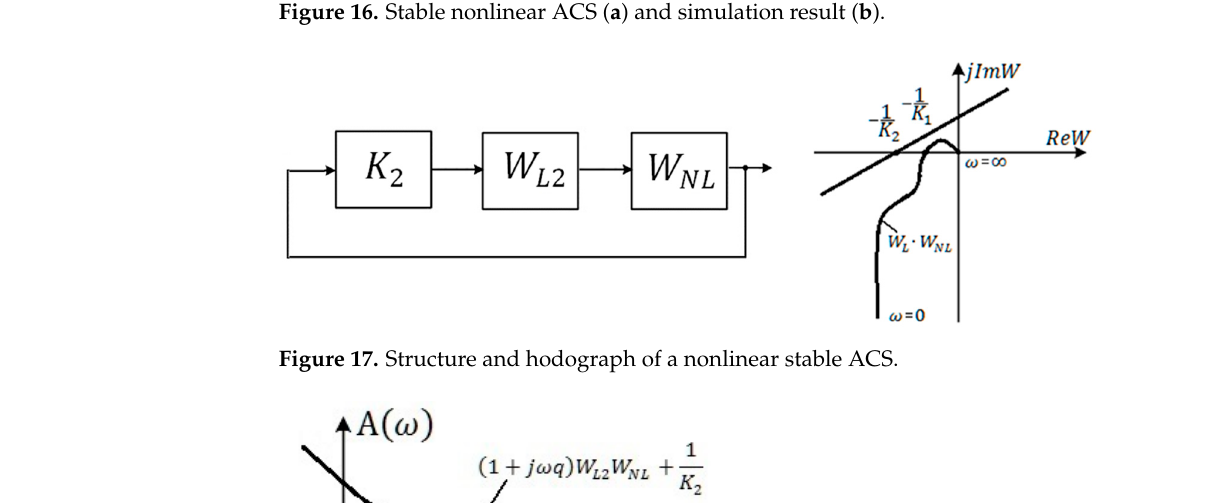
Figure 16. Stable nonlinear ACS ( a ) and simulation result ( b ).